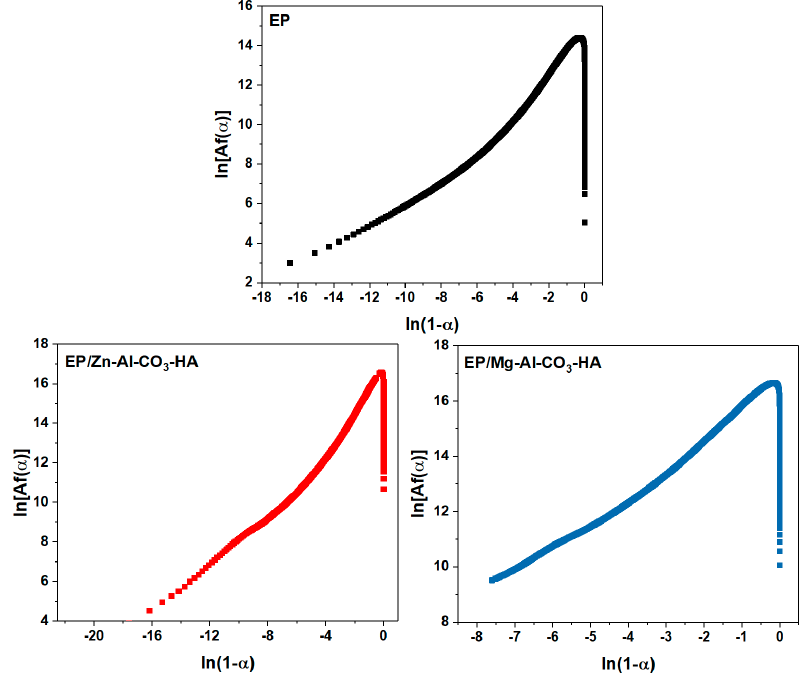
Figure B1. Plots of ln [ Af( α ) ] vs. ln(1 − α ) for the samples under a heating rate of 2 °C·min − 1.